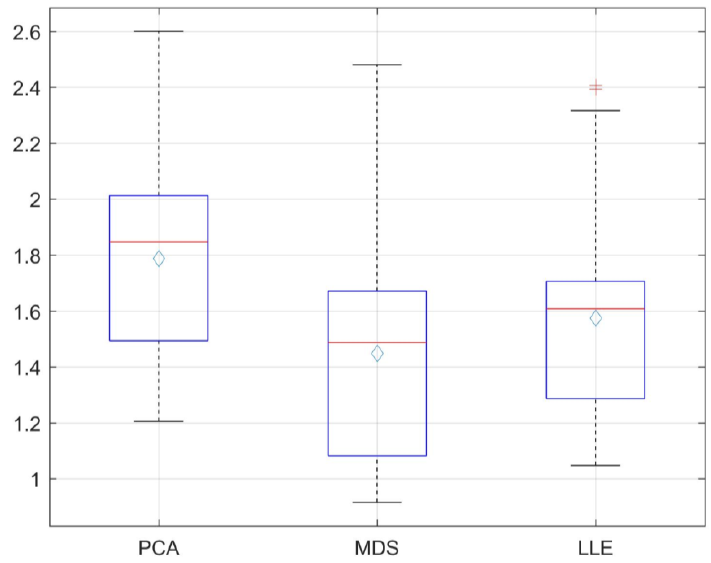
Figure 6. Boxplot of the RPD versus soil organic matter content estimation models using three